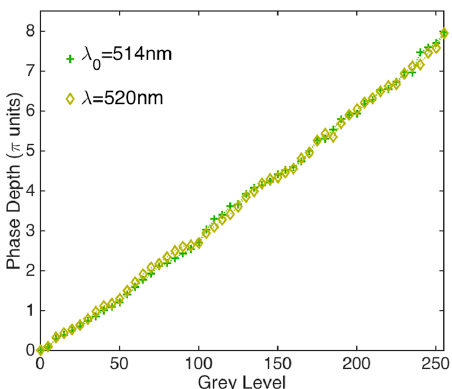
Figure 4. Phase modulation of the LCoS for two green wavelengths λ 0 = 514 nm (used in the characterization) and λ = 520 nm when the SLM display operates with the LUT that linearizes the 8 π phase modulation range for λ 0 = 514 nm (Figure 3b,c).